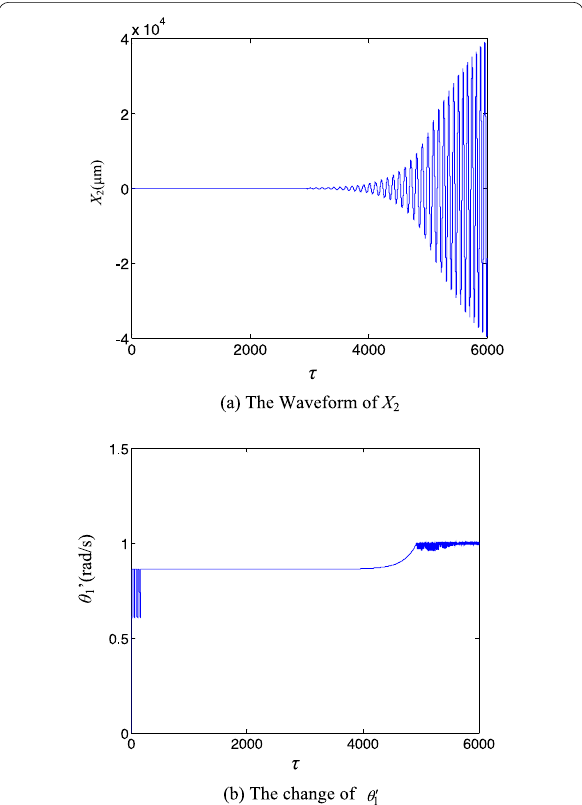
Figure 8 Change of motion state of the disc at ξ 2 = 0.1